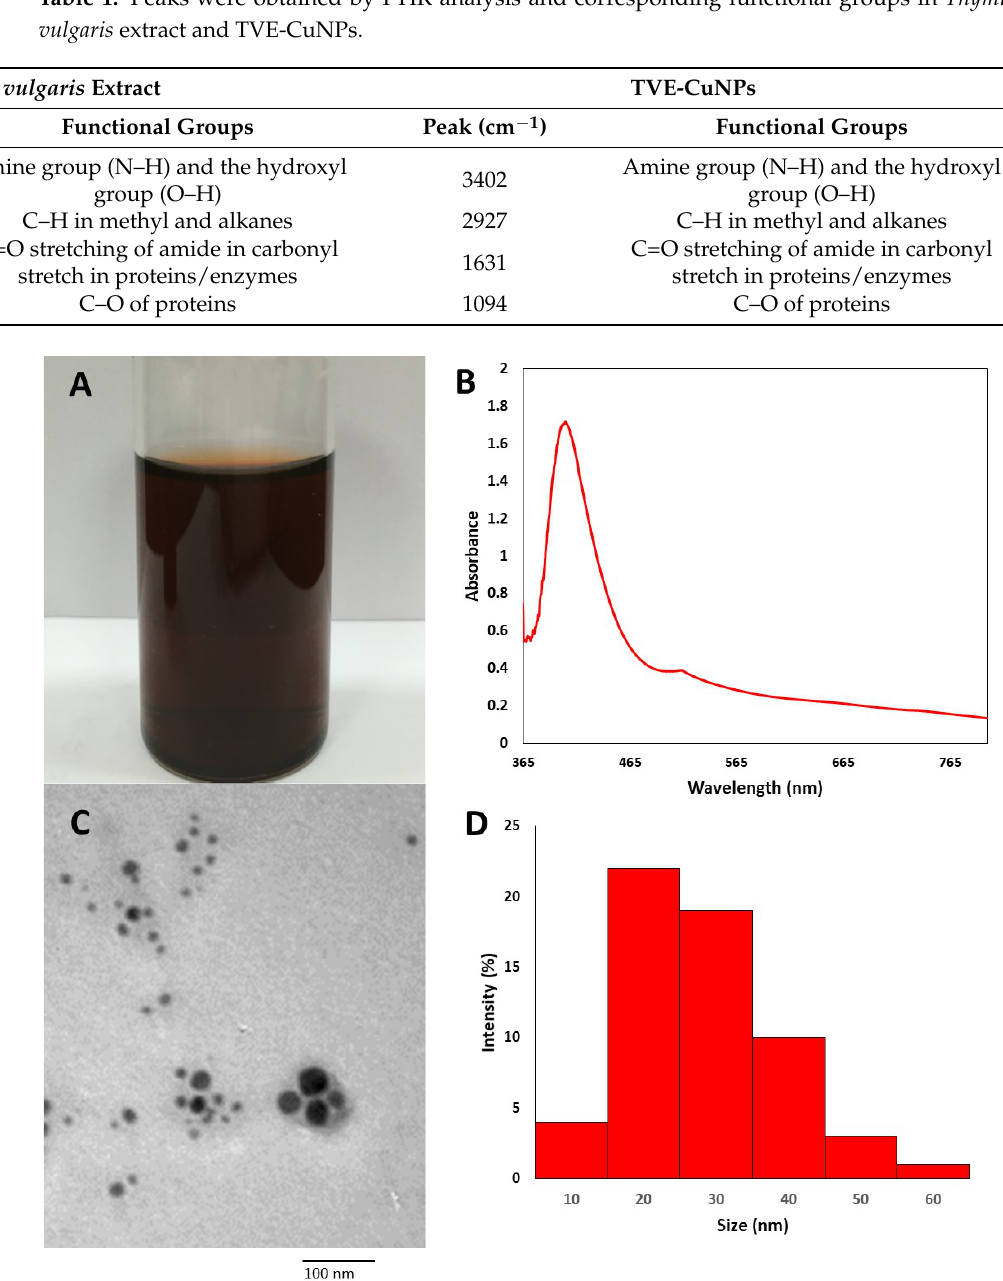
Figure 5. AgNPs characterizations: ( A ) AgNP solution; ( B ) UV–Vis spectrum absorption of the Figure 5. AgNPs c haracterizations: ( A ) AgNP solution; ( B ) UV–Vis spectrum absorption of the AgNPs; ( C ) AgNP TEM; and ( D ) AgNP size AgNPs; ( C ) AgNP TEM; and ( D ) AgNP size distribution.